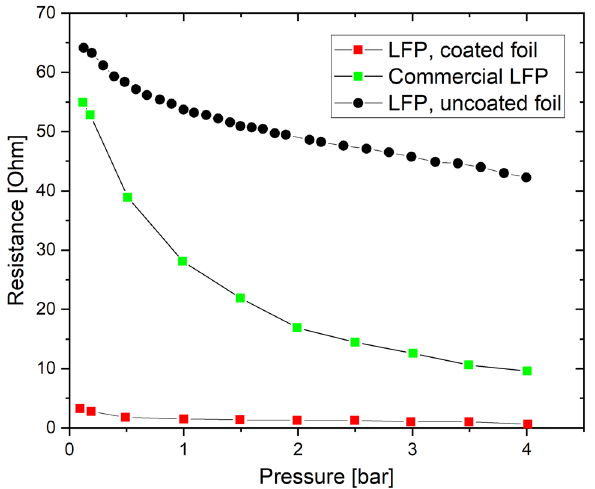
Fig. 2 Through-sheet resistance of dry, sandwiched electrodes with and without coating, and a commercial LFP cathode, as a function of pressure